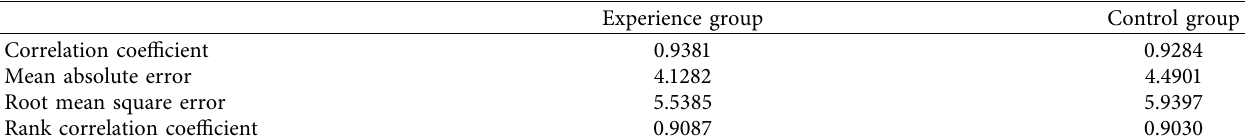
Table 4: Comparison of edge correction performance of JPEG distorted image.